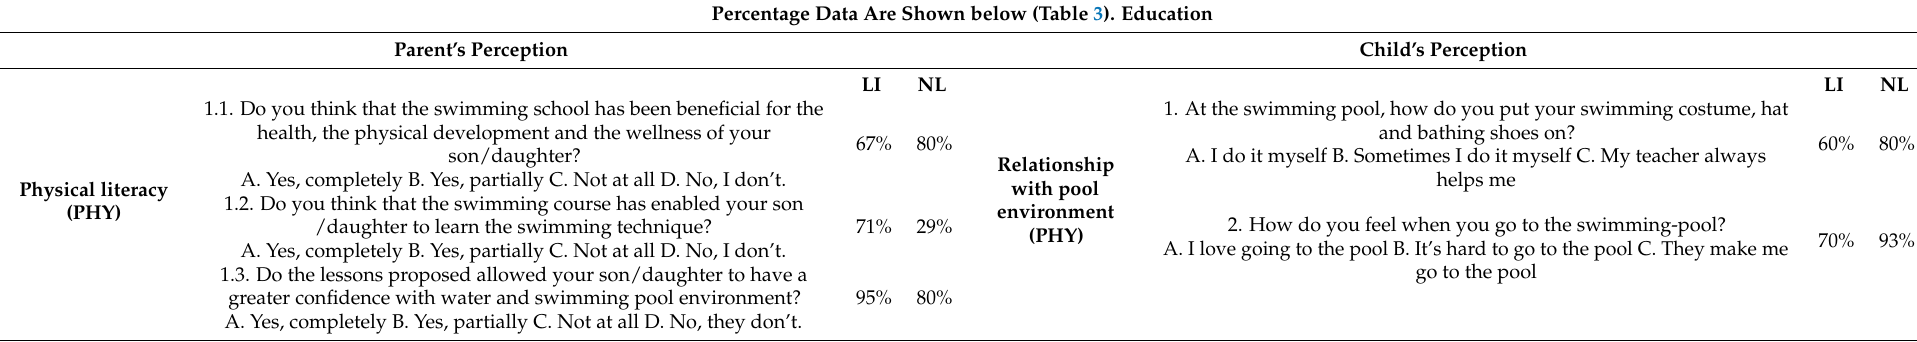
Table 3. The Table is divided into three thematic areas. On parents’ perception side, the first line refers to the physical literacy’s sphere, the second line is related to the child dimension and the last one regards with the aspects of the instructor. On children’s perception side, the first line refers to the relationship with the pool environment, the second one is related to the water competence and the last one regards with the psychosocial aspects. The three categories of parents’ perception emerged from the results of GT, of which the questionnaire has been structured on. The three categories of children’s perception have arbitrarily made to correspond to the emerging GT categories. The percentages considered refer to positive responses. Percentage Data Are Shown below (Table 3).